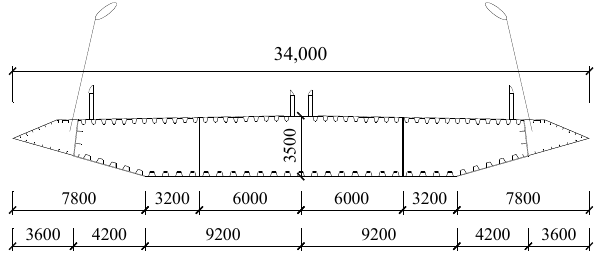
Figure 5. Finite element model of Xiangshan Harbor Bridge.